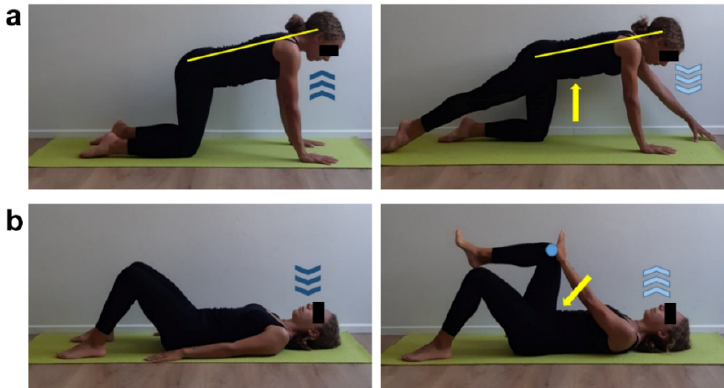
Figure 11. Thoraco-abdominal stabilization exercises. ( a ) Quadruped position, neutral spine attitude (yellow line), set hands shoulder-width apart and knees and feet hip-width apart. Inhale (dark blue arrows) and activate core muscles, then exhale (light blue arrows) while performing an extension of right lower limb and left upper limb keeping toes and fingertips in touch with the floor. Focus on hips-spine-shoulders-head alignment (yellow line), core muscles activation (yellow arrow) and feel upper limb stretching forward and lower limb backward. Two sets of 6 repetitions, 1 min recovery. ( b ) Supine position, rest straight arms by body sides and hand palms on the floor, flex both legs and place feet hip-width apart on the floor, inhale (dark blue arrows). Lift right lower limb keeping 90 degrees flexed leg and forming a 90 degrees angle between thigh and upper body, place left hand palm on right knee without touching it by fingers (light blue dot), exhale (light blue arrows) while performing an opposite push between hand palm and knee. Slowly get back to start position. Repeat with opposite hand/knee. Focus on performing opposite push until the exhalation phase is completed and perceiving an abdomen downward retraction (yellow arrow).